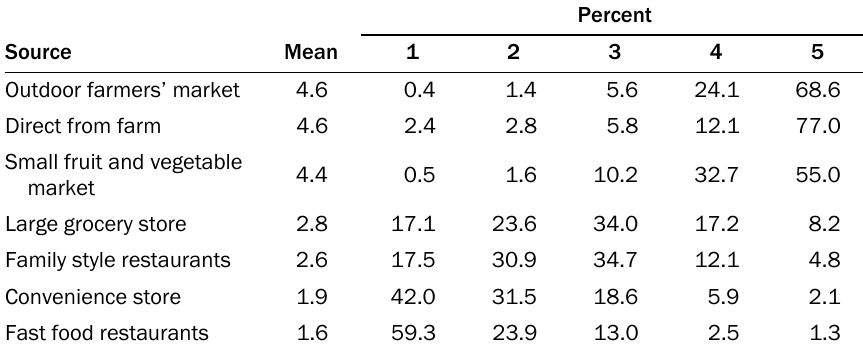
Table 4. Respondents’ Opinions Regarding Sources of Local Foods, by Rating